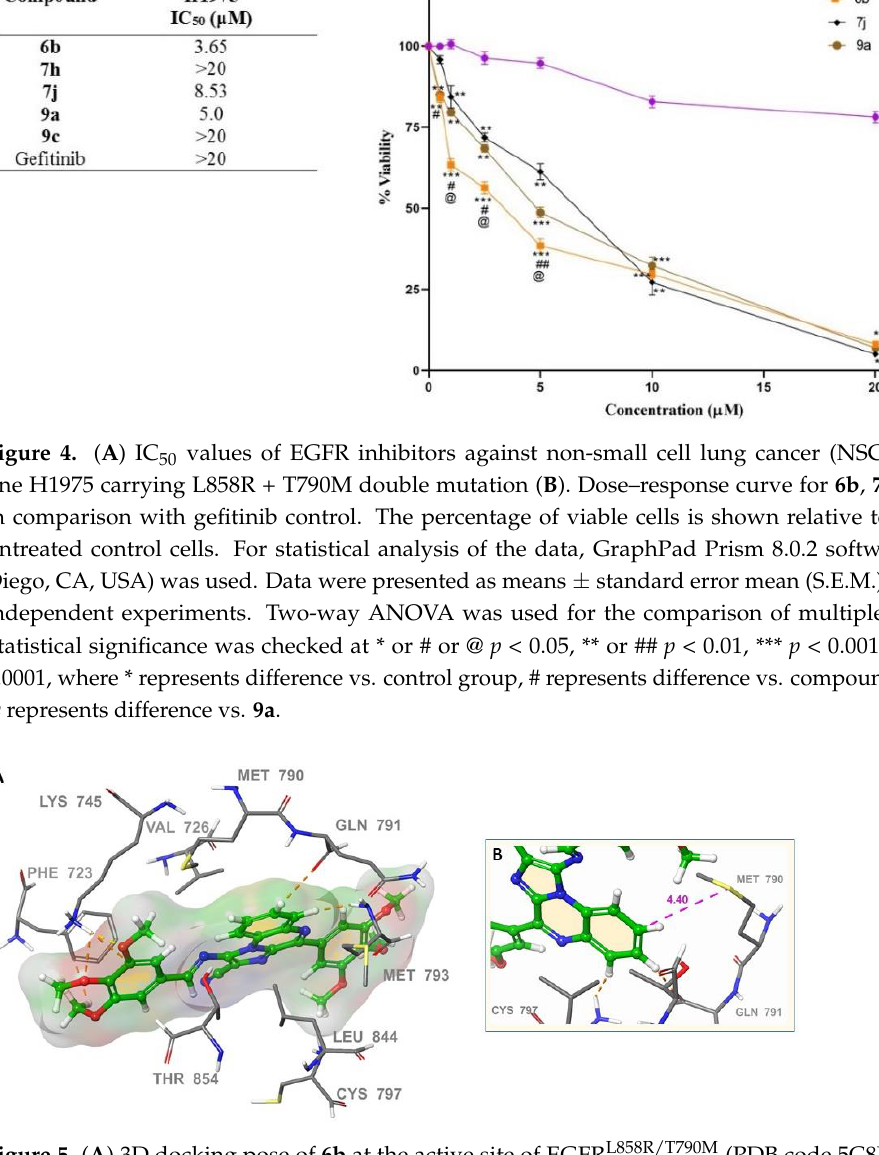
Figure 4. ( A ) IC 50 values of EGFR inhibitors against non-small cell lung cancer (NSCLC) cell line H1975 carrying L858R + T790M double mutation ( B ). Dose–response curve for 6b , 7j and 9a in comparison with gefitinib control. The percentage of viable cells is shown relative to that of un- treated control cells. For statistical analysis of the data, GraphPad Prism 8.0.2 software (San Diego, CA, USA) was used. Data were presented as means ± standard error mean (S.E.M.) of three inde- pendent experiments. Two-way ANOVA was used for the comparison of multiple groups. Statisti- cal significance was checked at * or # or @ p < 0.05, ** or ## p < 0.01, *** p < 0.001, **** p < 0.0001, where * represents difference vs. control group, # represents difference vs. compound 7j and @ represents difference vs. 9a .